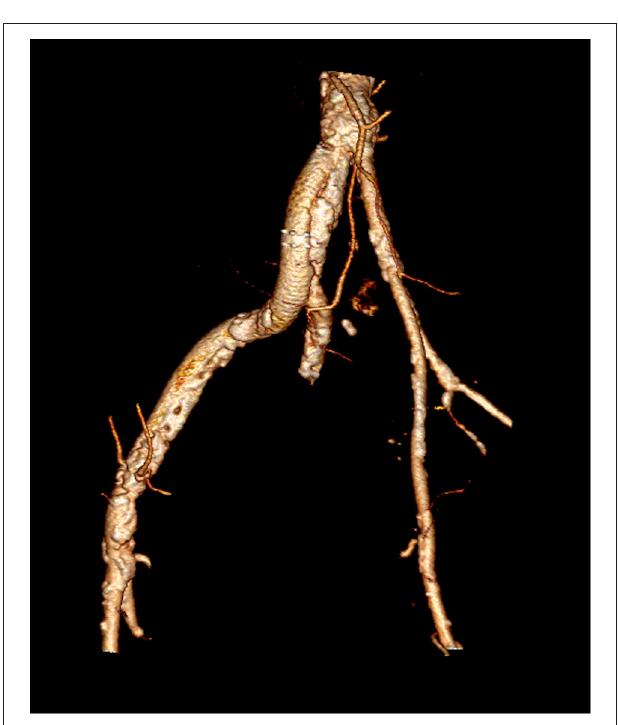
- Chronic lung disease: the patient was on domiciliar oxygen therapy since 2014, but there was no recent pneumologic